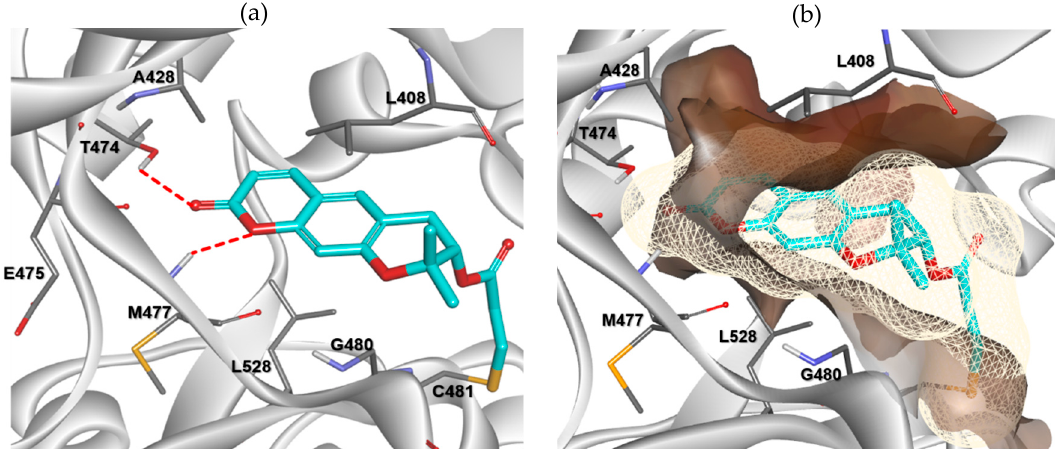
Figure 4. Predicted binding mode of compound 8 (cyan) with BTK (PDB code: 6O8I). ( a ) Key interactions of compound 8 with BTK. H-bonds to the protein are shown, denoted by red dashed lines. The side chains of the active site residues are represented by white sticks. ( b ) The hydrophobicity map surrounding compound 8 in the active site of BTK. The hydrophobic interactions are shown by surface representation.